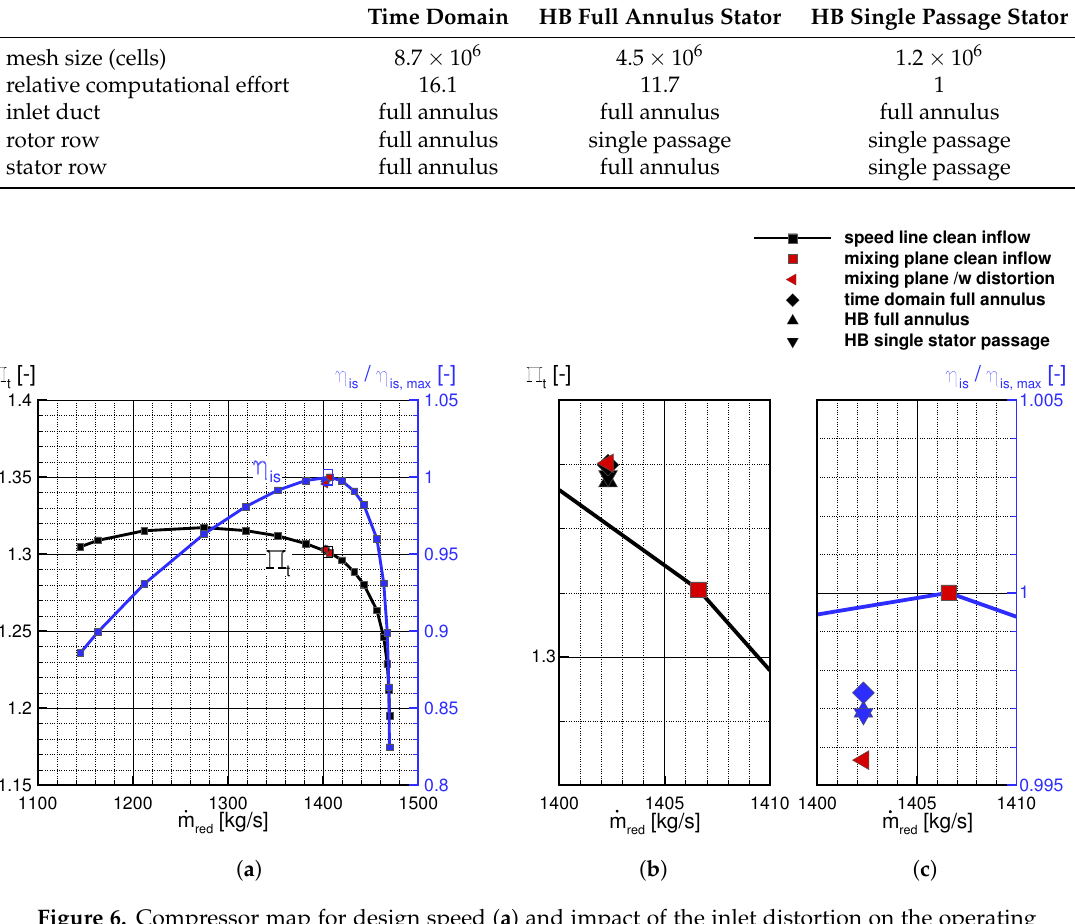
Figure 6. Compressor map for design speed ( a ) and impact of the inlet distortion on the operating point. Zoom of total pressure ratio ( b ) and isentropic efficiency ( c )